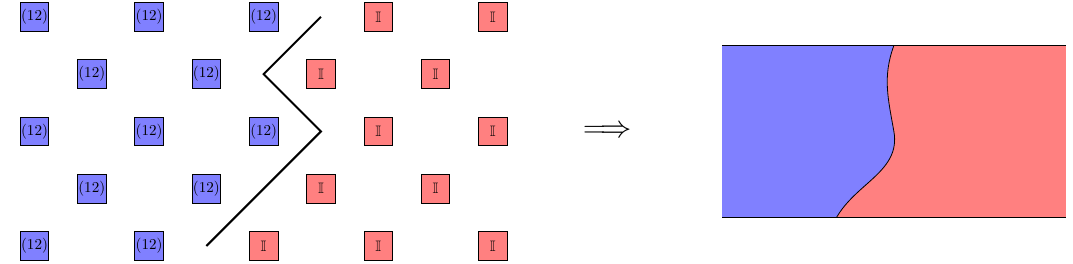
Figure 11 . Statistical model in terms of domain walls. Left: domain wall con(cid:12)gurations for the 2nd R(cid:19)enyi entropy. Right: coarse grained domain wall con(cid:12)guration. Red and blue represent two do- mains of permutation extended from the boundary twist imposed by the de(cid:12)nition of entanglement.